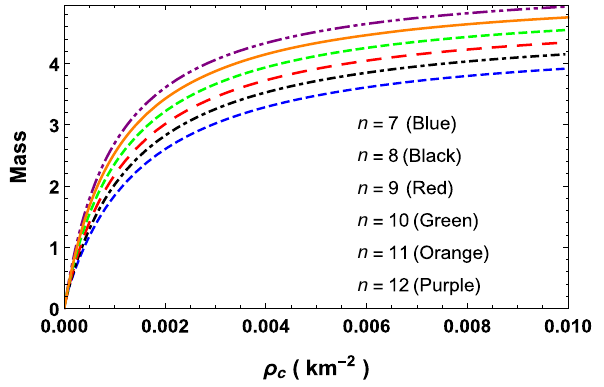
(cid:9) (cid:8) (cid:8) (cid:9) M max , I M , I max and blue dots